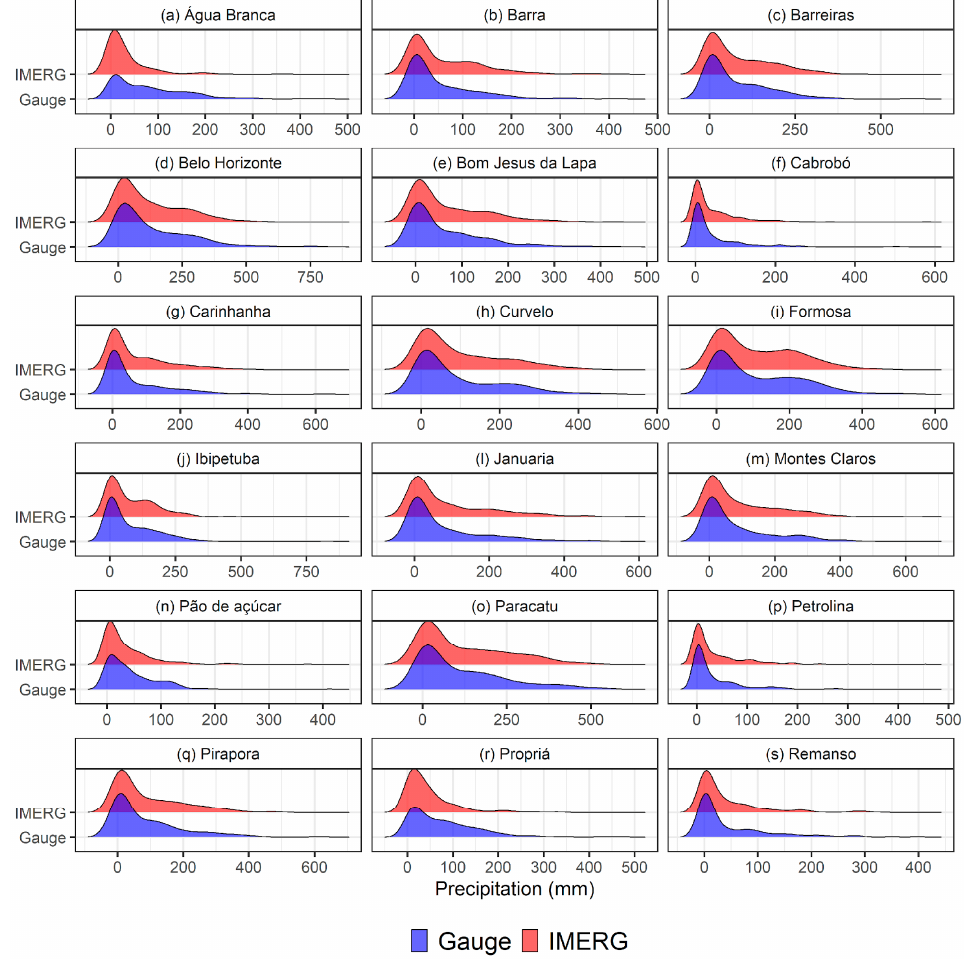
Figure 5. Precipitation density curves observed by rain gauges and IMERG at each gauge ( a ) Água Branca, ( b ) Barra, ( c ) Barreiras, ( d ) Belo Horizonte, ( e ) Bom Jesus da Lapa, ( f ) Cabrobó, ( g ) Carinhanha, ( h ) Curvelo, ( i ) Formosa, ( j ) Ibipetuba, ( l ) Januaria, ( m ) Montes Claros, ( n ) Pão de açúcar, ( o ) Paracatu, ( p ) Petrolina, ( q ) Pirapora, ( r ) Propriá, ( s ) Remanso. Table 2. Estimates of the parameters ( β 0 and β 1 ) of the linear regression model, the determination coefficient (R 2 ), correlation coefficient (r), the corresponding p